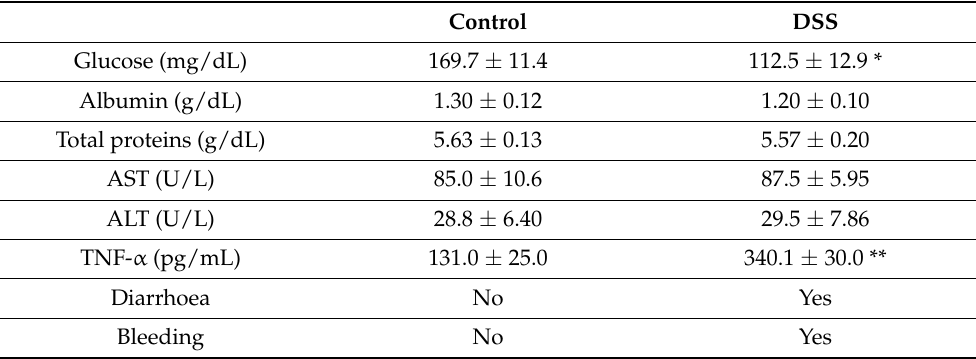
Table 1. Biochemical parameters in serum obtained from rat with colitis induced by DSS for 5 days. Healthy rats (Control group) and rats subjected to experimental colitis (treated with DSS). Values are the mean ± SD. Data were analyzed by student’s t -test. (* p < 0.05, ** p <